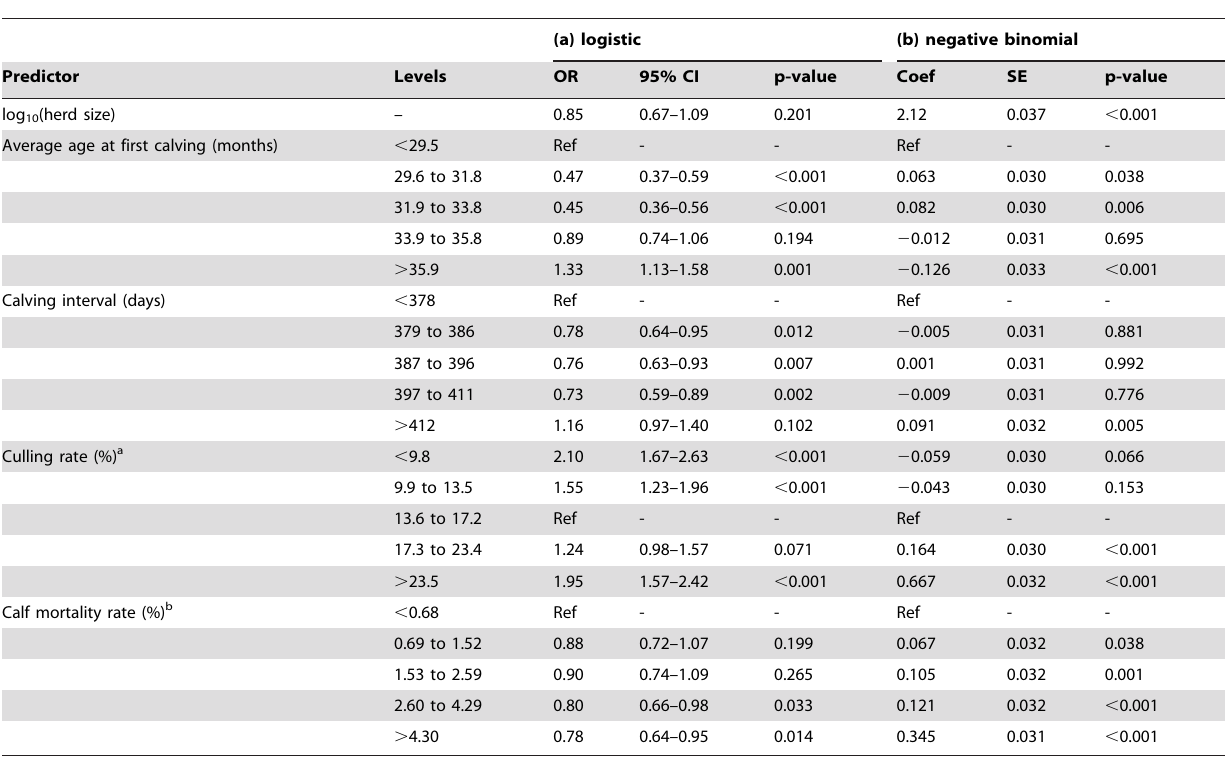
Table 1. Zero-inflated negative binomial regression model for beef herds.